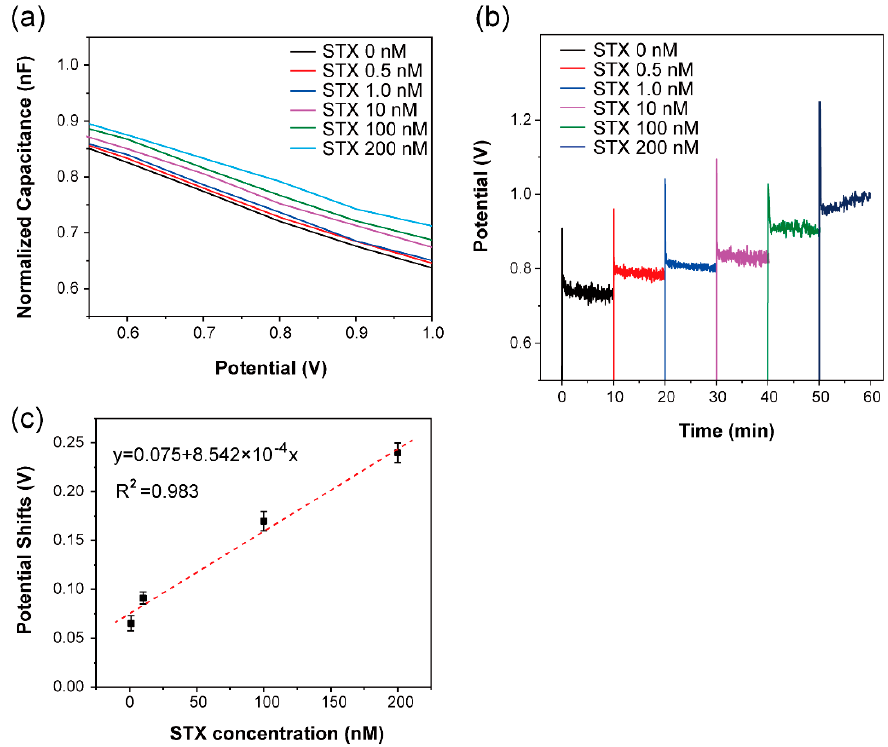
Figure 4. ( a ) C-V curves and ( b ) ConCap measurements of the biosensor to STX (from 1.0 nM to 200 nM). ( c ) Statistical results of ConCap measurements; the experiment was repeated three